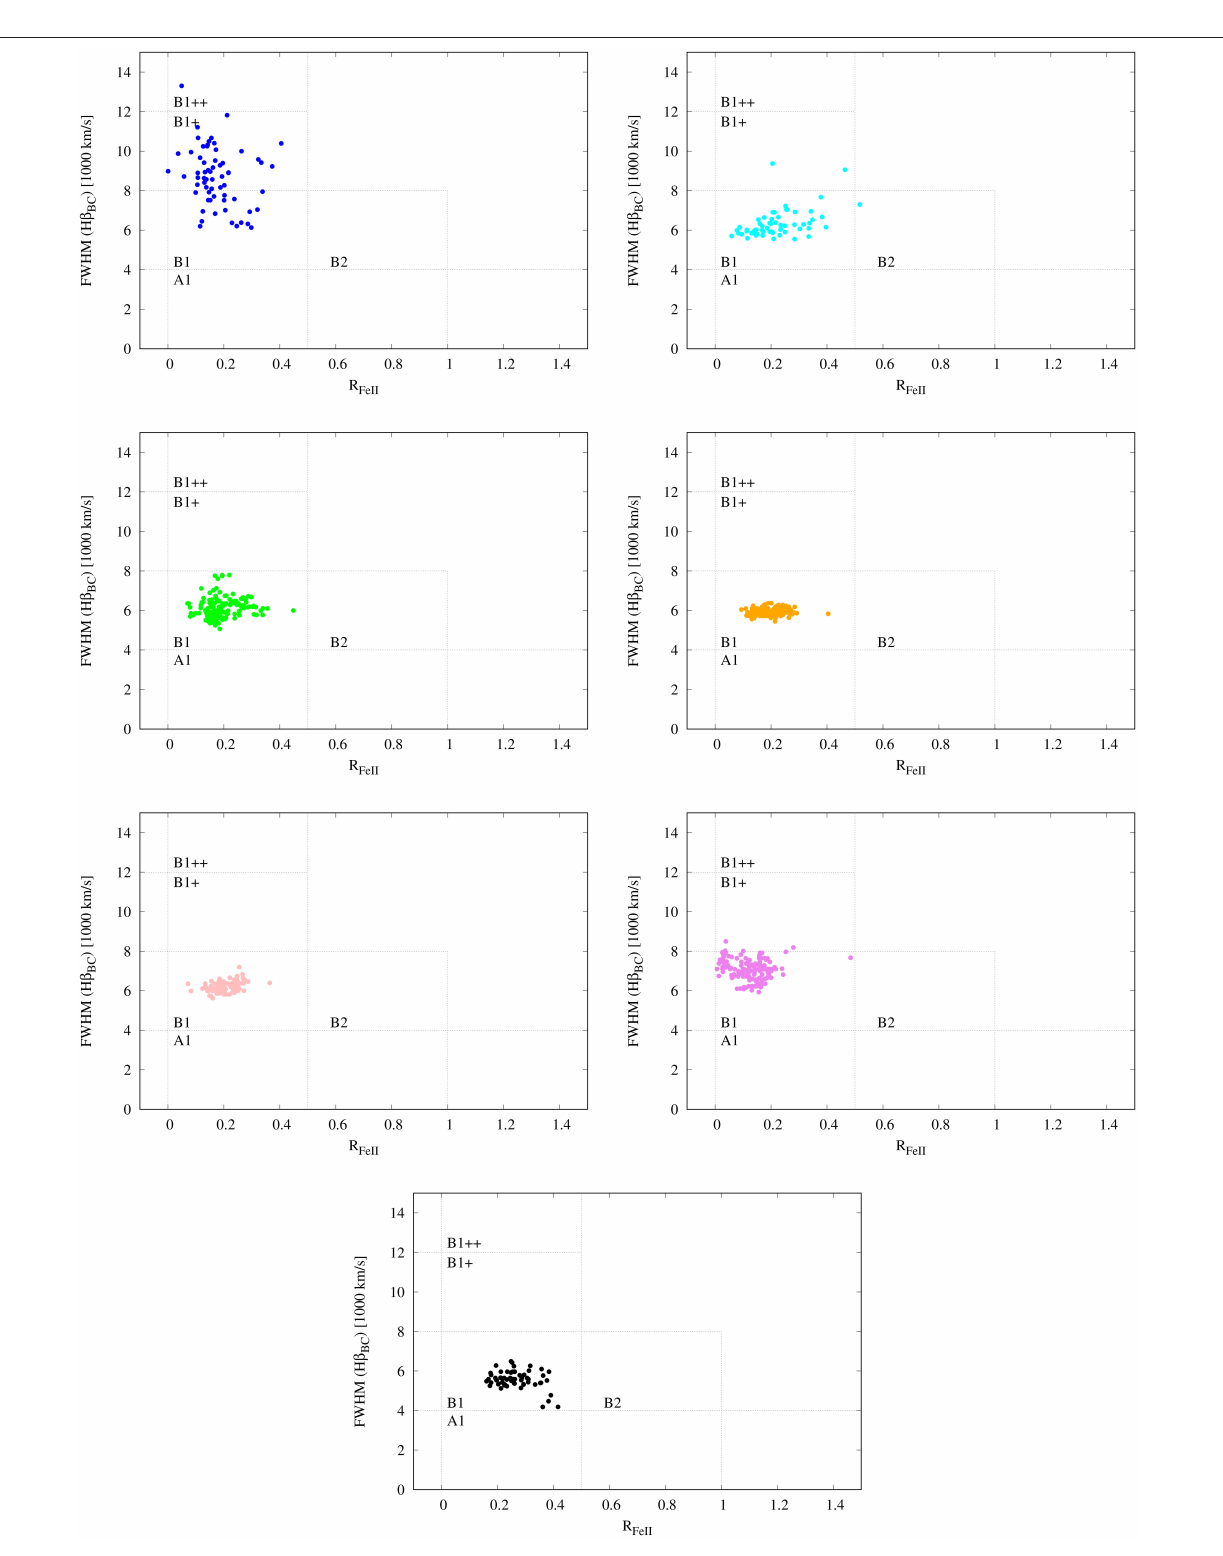
Frontiers in Astronomy and Space Sciences | www.frontiersin.org